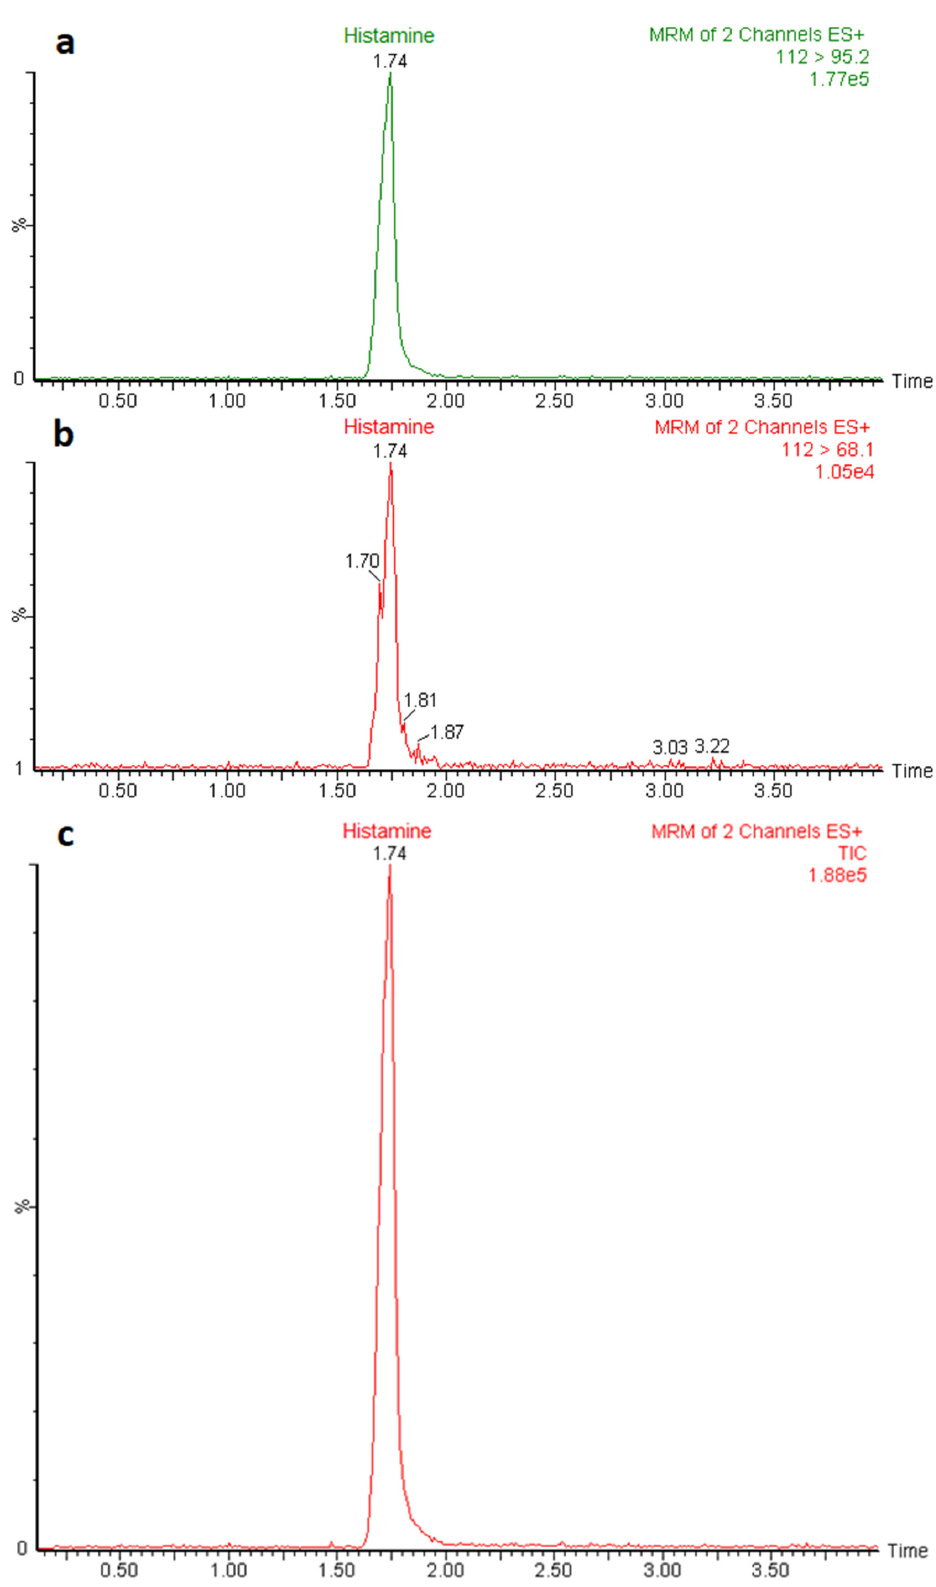
Figure 2. Chromatograms obtained after LC-MS/MS analysis of a histamine standard solution at 25 ng/mL level representing the quantitation ( m / z 112 > 95.2) ( a ) and confirmation ( m / z 112 > 68.1) ( b ) MRM transitions, and total ion current (TIC) chromatogram ( c